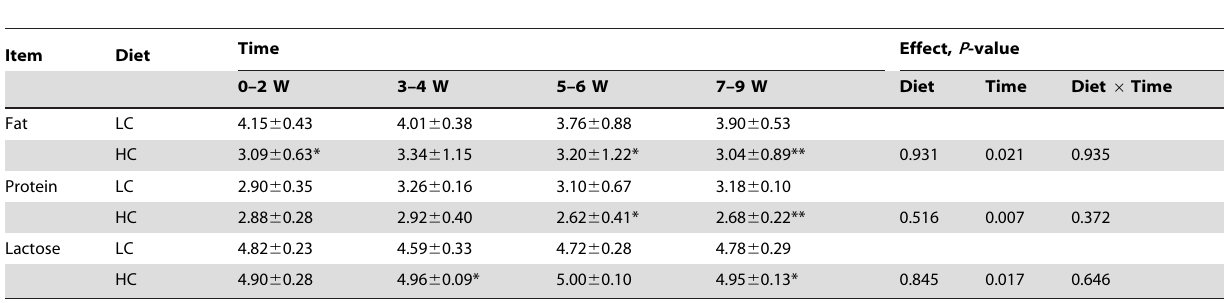
Table 2. The percentage of fat, protein, and lactose in milk from control and treatment group goats.